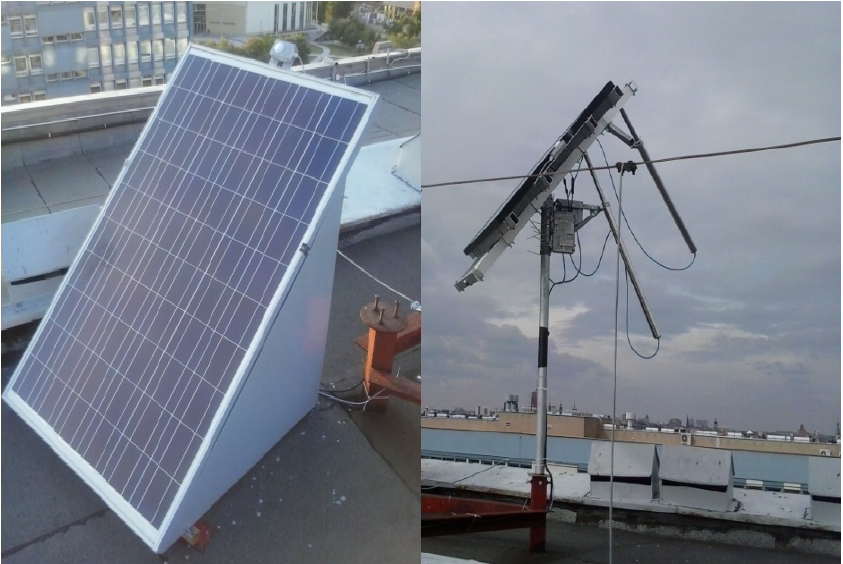
Figure 10. Image of the fixed and tracking photovoltaic system installed on the rooftop of the building of the Poznan University of Technology. of the Poznan University of